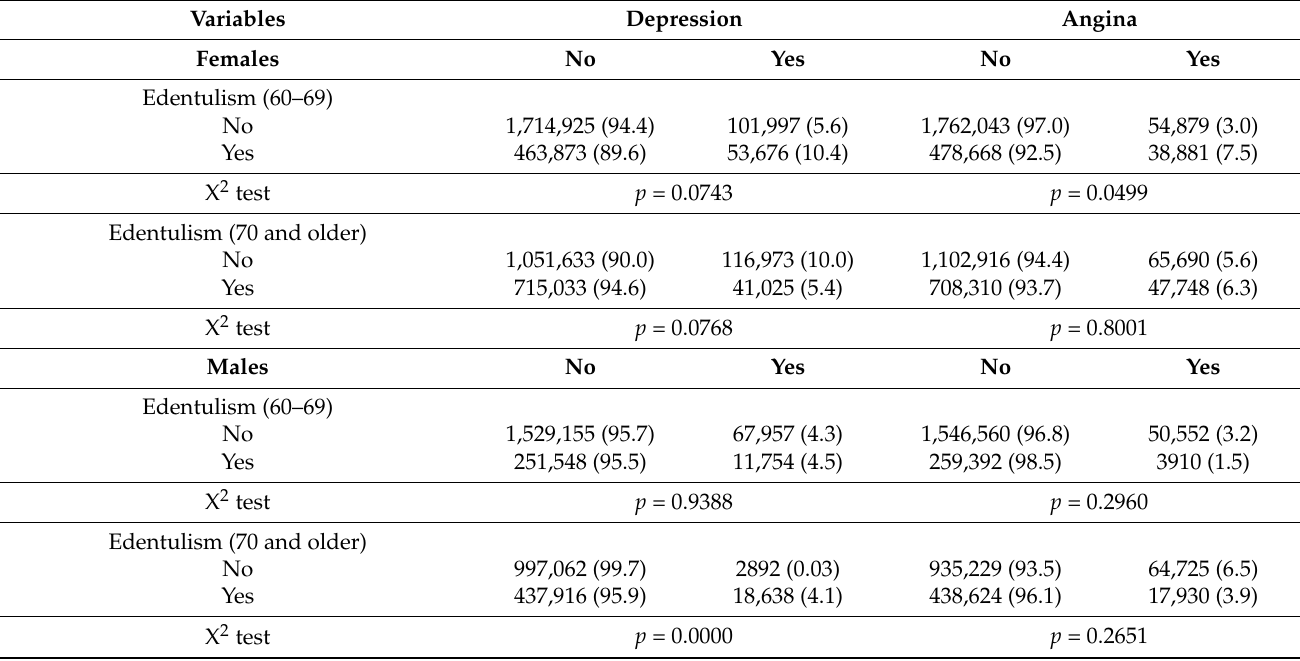
Table 4. Distribution of edentulism due to depression and angina stratified by age group and sex (estimated population N = 7,576,057).